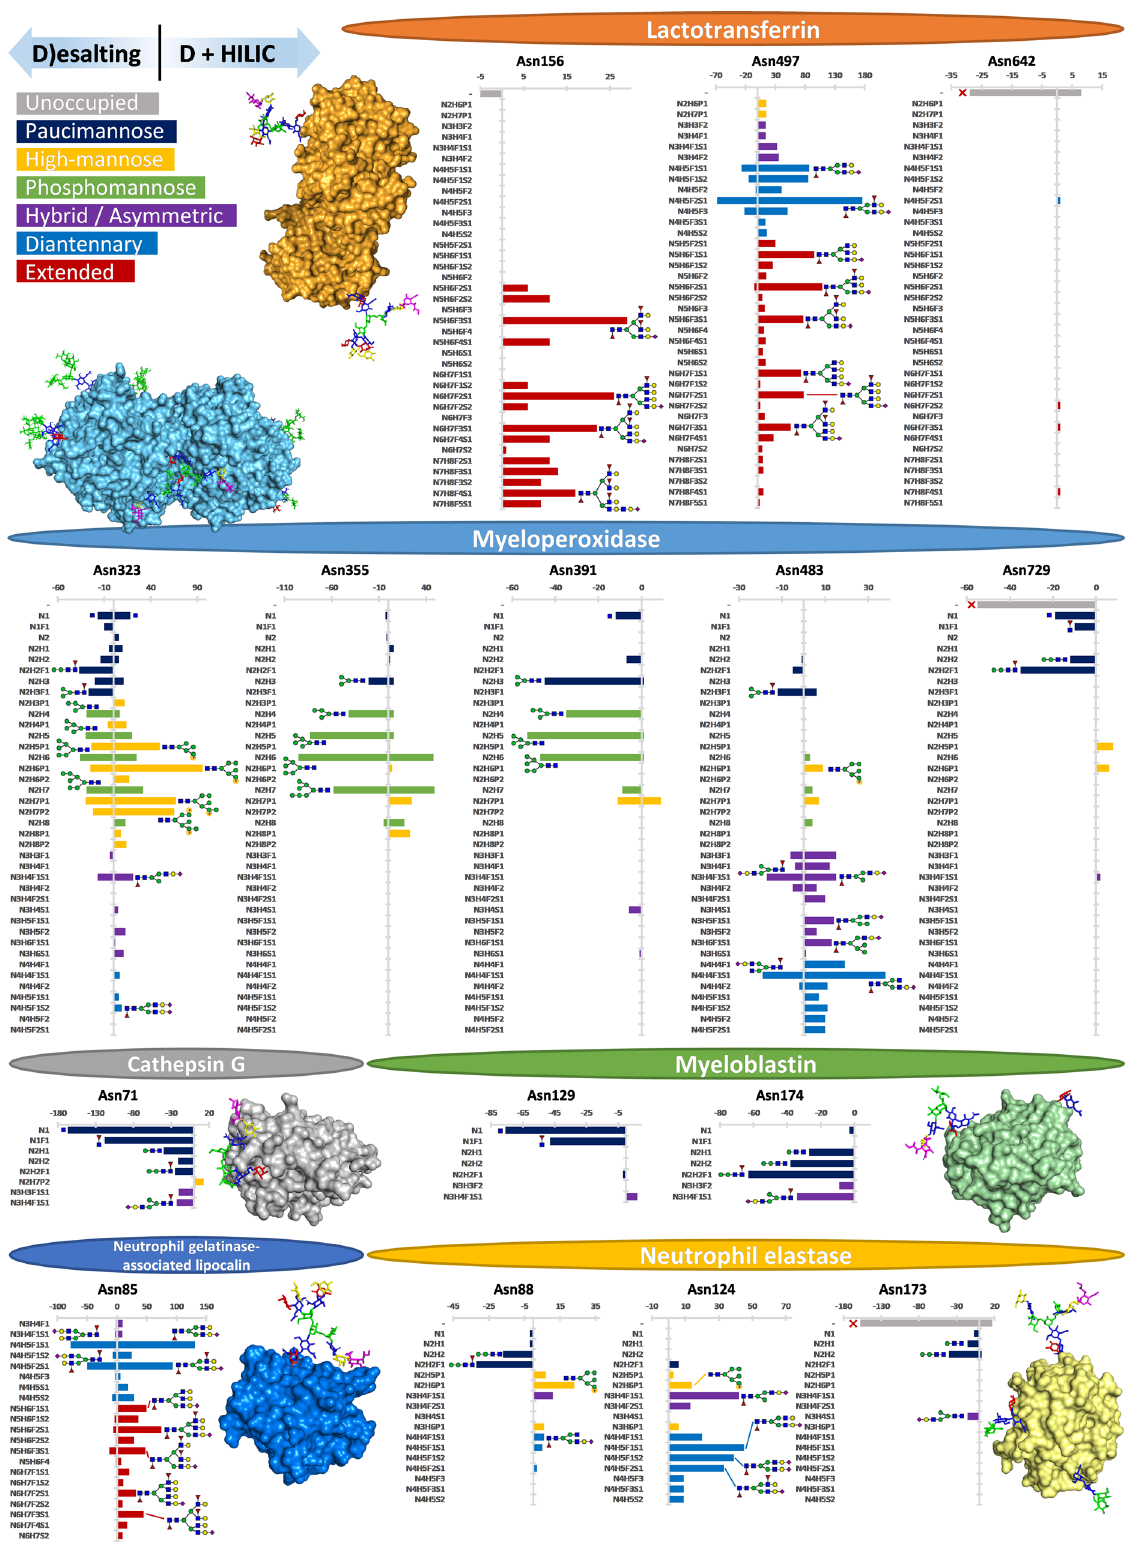
Fig. 6 Site-speci fi c glycosylation detected on six major neutrophil proteins. Glycan species were only included in the comparison when at least nine glycopeptide PSMs were detected for any glycosylation site of that protein after either desalting-only (left) or desalting + HILIC (right). Glycoprotein structures were generated by energy-minimization of the glycan on an existing PDB structure by GLYCAM (www.glycam.org). As mass spectrometry does not principally distinguish glycan isomerism, the proposed glycan structures are only estimated on basis of the literature. As can be seen, while proteins exhibited overall glycosylation characteristics such as high complexity (lactotransferrin, neutrophil gelatinase-associated lipocalin) or low complexity (myeloperoxidase, cathepsin G, myeloblastin, neutrophil elastase), they also showed considerable site-dependent heterogeneity (meta-heterogeneity) within the same